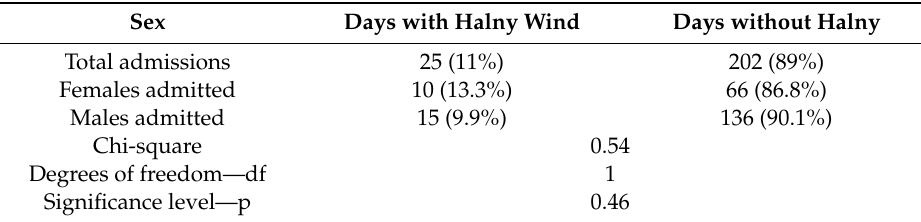
Table 3. Admissions in months with halny wind. Number of admissions on halny days vs. remaining days.